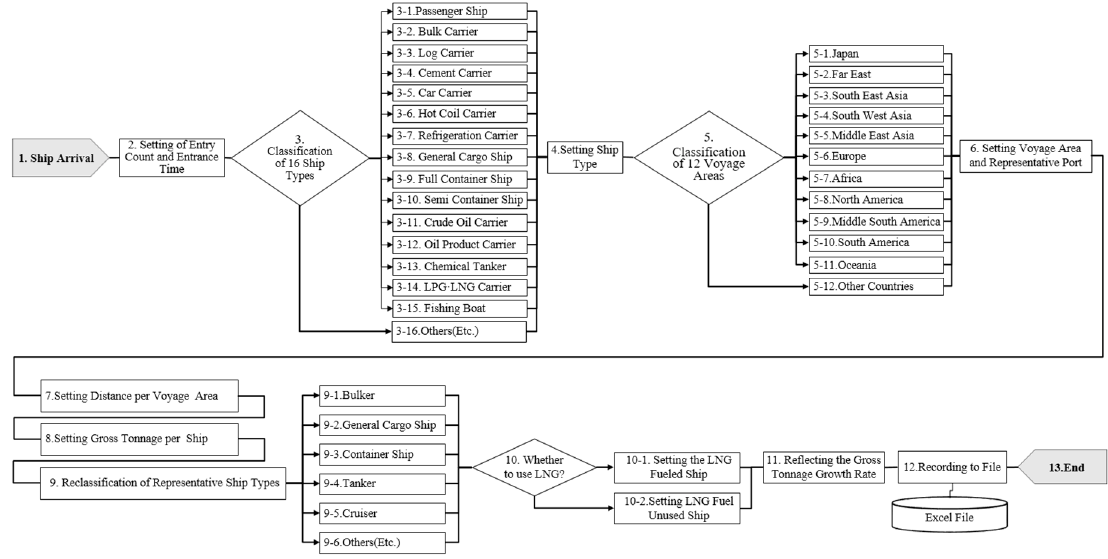
Figure 9. Simulation Modeling Process.